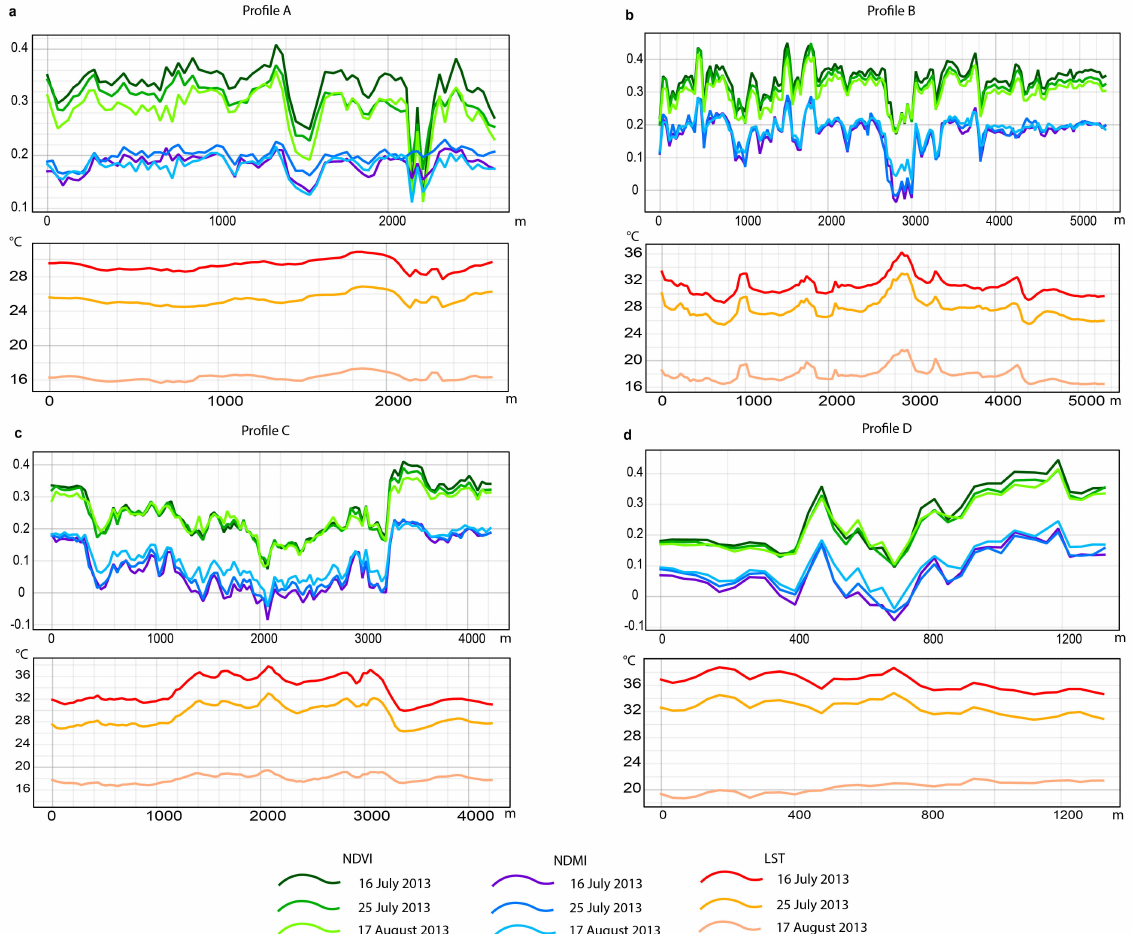
Figure 4. Changes in the vegetation indices and LST along: ( a ) profile «A»; ( b ) profile «B»; ( c ) profile «C»; ( d ) profile «D» (calculated for three summer dates, 16 July 2013, 25 July 2013, and 17 August 2013, based on the results of image processing